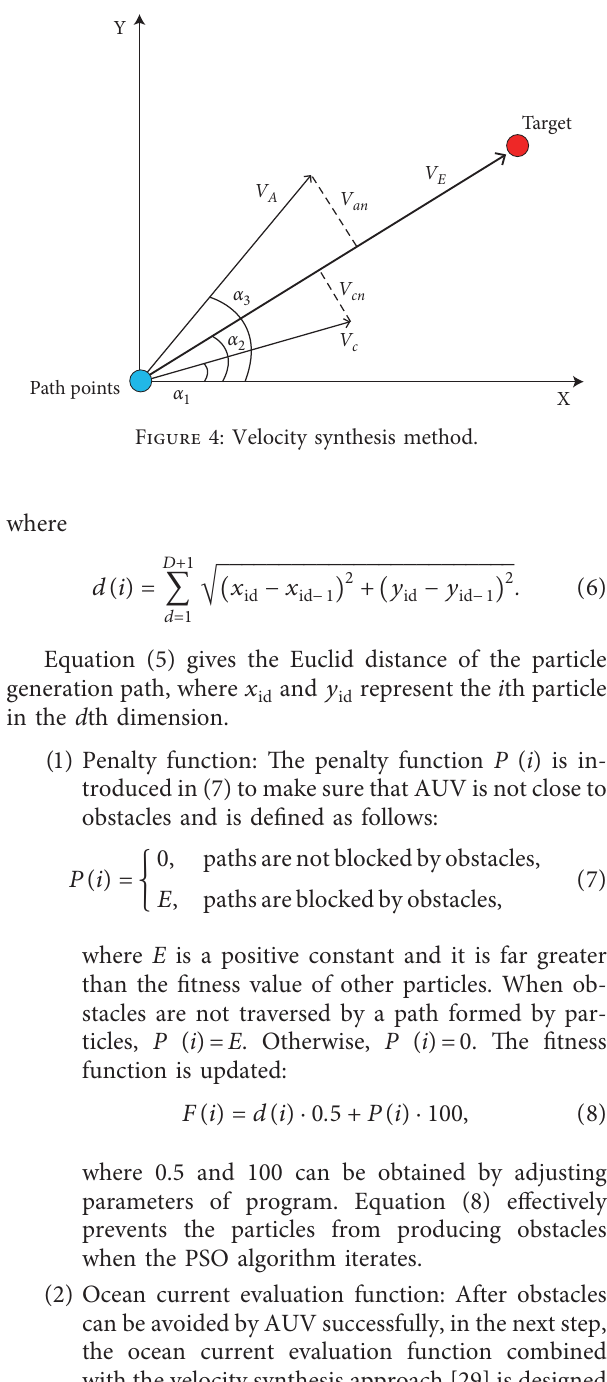
Path Figure 4: Velocity synthesis